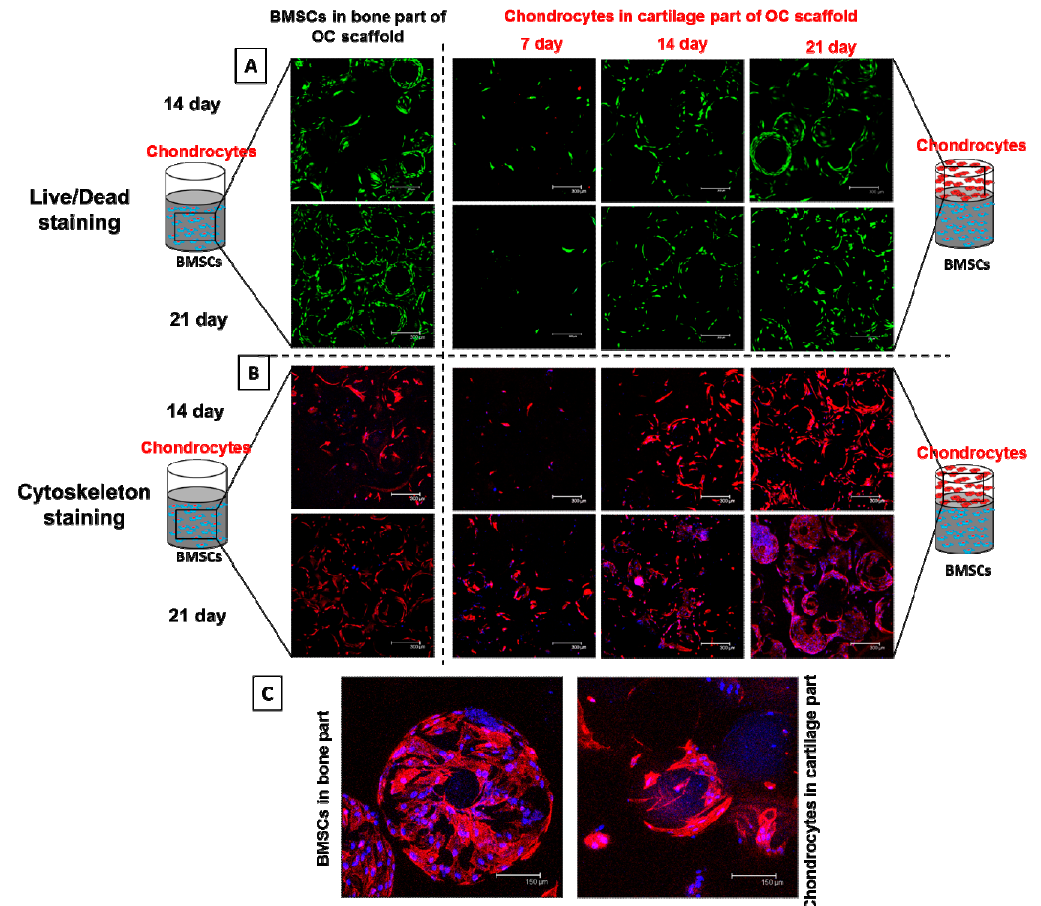
Figure 9. Live/Dead cell assays ( A ) and cytoskeletal arrangement determined by phalloidin/DAPI staining ( B ) of co-cultured BMSCs and chondrocytes in OC scaffolds. Bar = 300 µm; ( C ) The cytoskeletal arrangement of BMSCs and chondrocytes on a single microsphere surface in the bone and cartilage part at day 14. Bar = 150 µm.